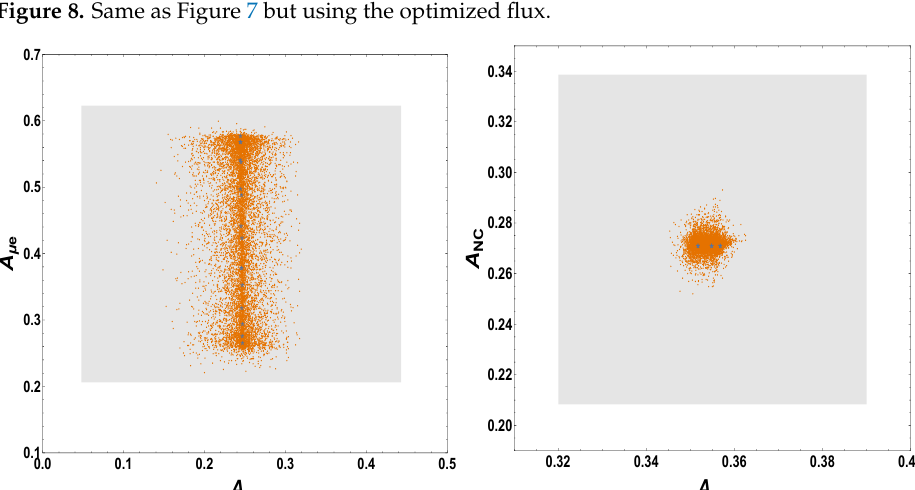
Figure 9. Integrated asymmetries in the ( A µτ , A µ e ) ( left plot) and ( A µµ , A NC ) planes ( right plot) in the sterile neutrino model. The adopted legend for the symbols is the same as for the other plots. Standard neutrino flux has been employed to compute the number of